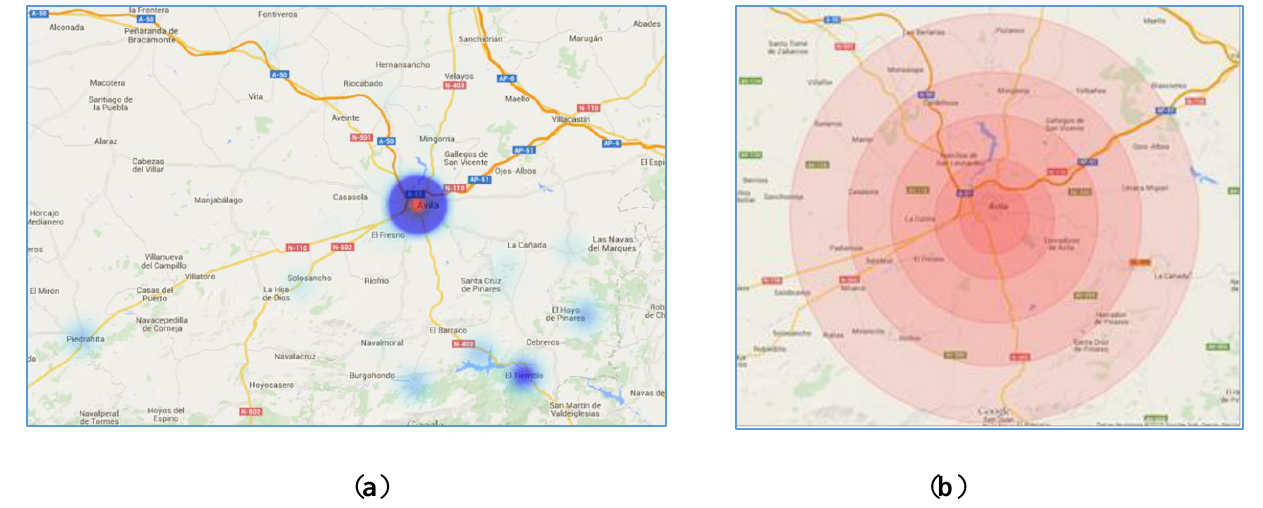
Figure 1. ( a ) Population dispersion: Map of roads and location of the population in the province of Ávila; ( b ) Radial